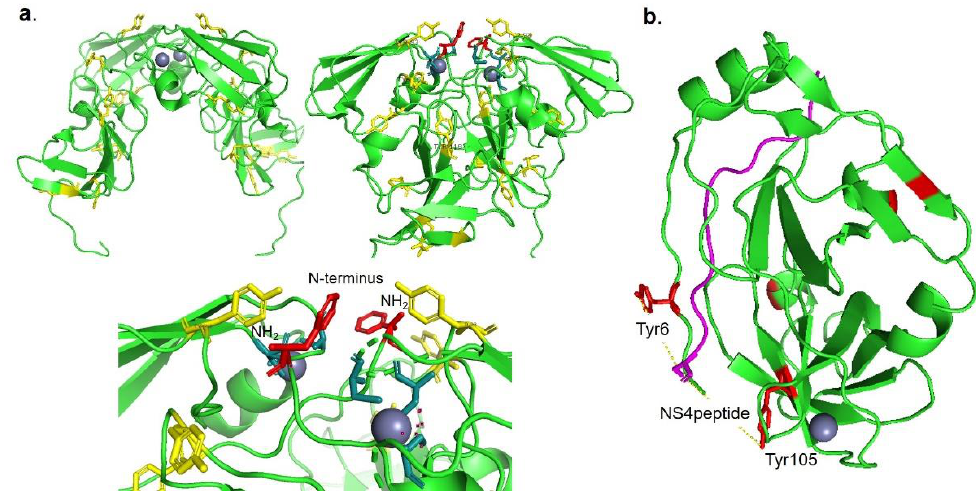
Figure 8. ( a ) 3D structure of the phosphoprotein NS5A, in dimeric form. Seven tyrosine residues (yellow) in each monomer, with one tyrosine in the N-terminal end (red). ( b ) 3D structure of the NS3 protease including the NS4 peptide (pink), showing the tyrosine residues in red. Structure was obtained from PDB with the following codes: 1zh1 (NS5) and 1jxp (NS3). Figures were drawn using Pymol program.